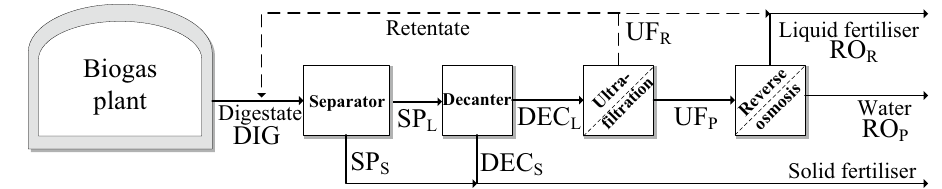
Fig. 1 Process scheme of the total conditioning process with ultra- filtration membrane and reverse osmosis; DIG digestate, SP L liquid screw press separator, SP S solid screw press separator, DEC L liquid